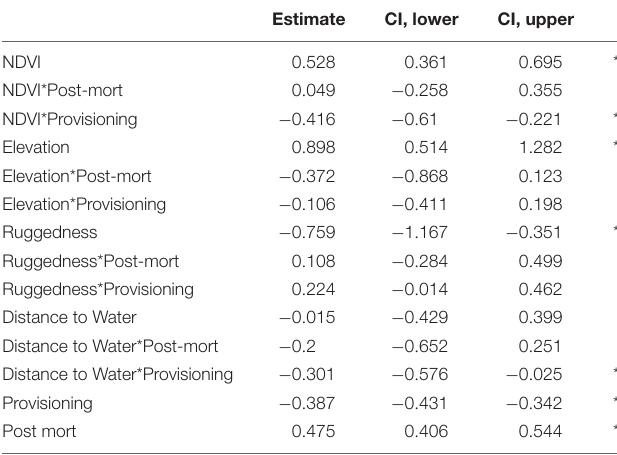
TABLE 2 | Coefficients from a generalized linear mixed model in which resource selection was modeled as a function of (standardized) NDVI, elevation, ruggedness, and distance to water.